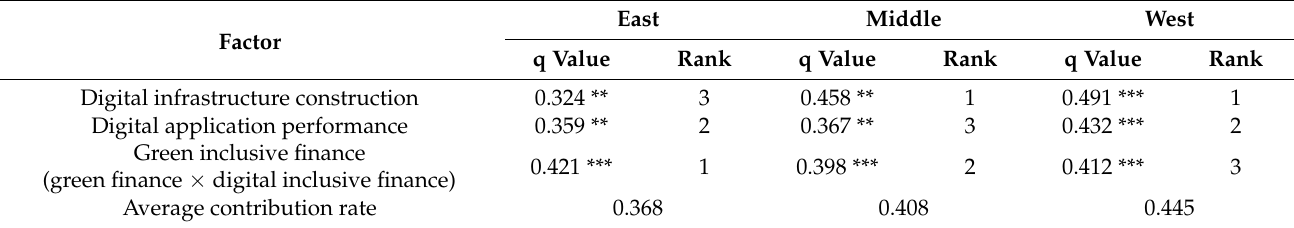
Table 6. Detection results of local digital drivers from 2010 to 2019.